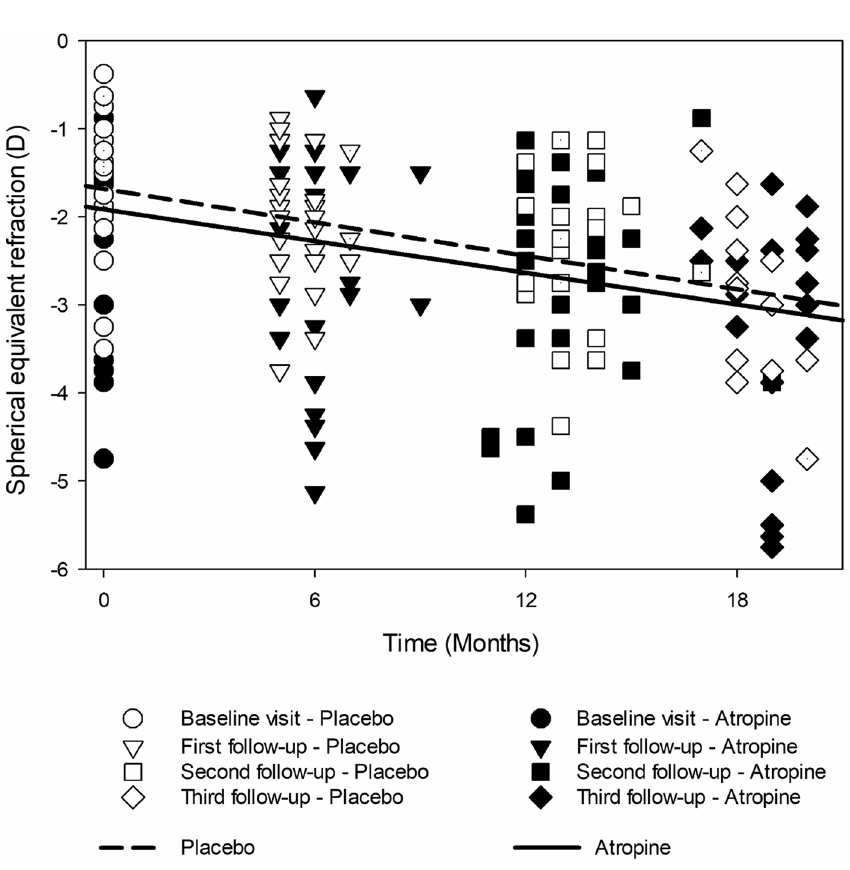
Figure 3. SER over time. Symbols represent individual SER by treatment group and visit, and lines represent mean SER over time by treatment group (as calculated by GLM). The slope of the lines indicates annualized change in SER: placebo group −0.66 (0.41) D, atropine group −0.70 (0.39)